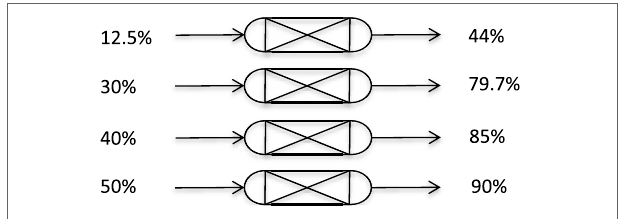
FigUre 11 | Various composition range inputs and outputs from the pressure swing adsorption